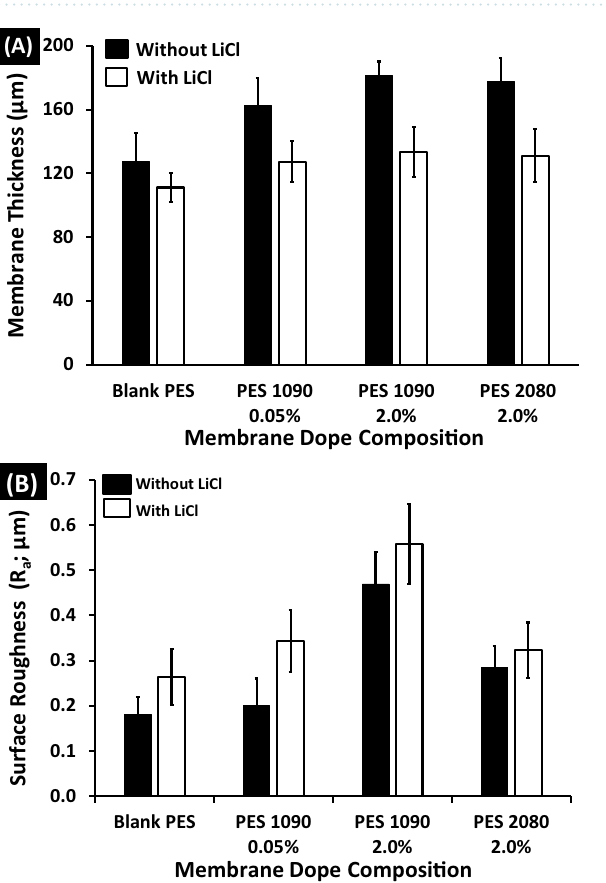
Figure 7. Surface thickness ( A ) and membrane roughness ( B ) of both the blank PES and the magnetic mixed matrix PES membranes as a function of membrane dope composition; wt% alloy concentration, in case of absence (black bars) and in case of using 0.1 wt% of Lithium chloride (white bars) in the membrane